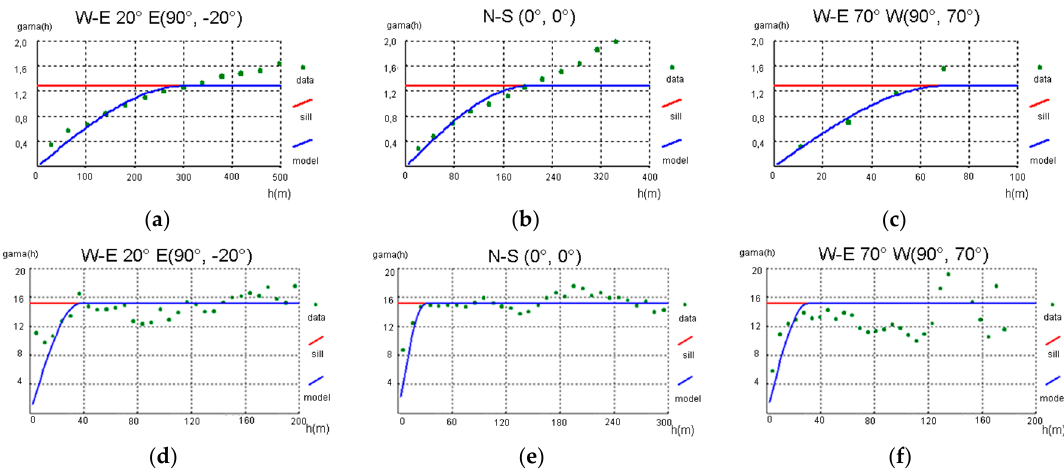
Figure 4. Experimental variograms of P ( x ) and Y Cu (x) variables for the three mentioned directions: W-